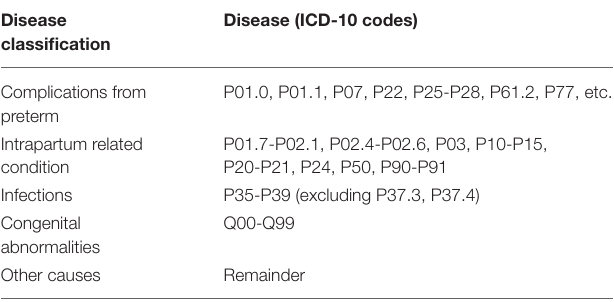
TABLE 3 | Cause of neonatal death categories and ICD-10 codes.